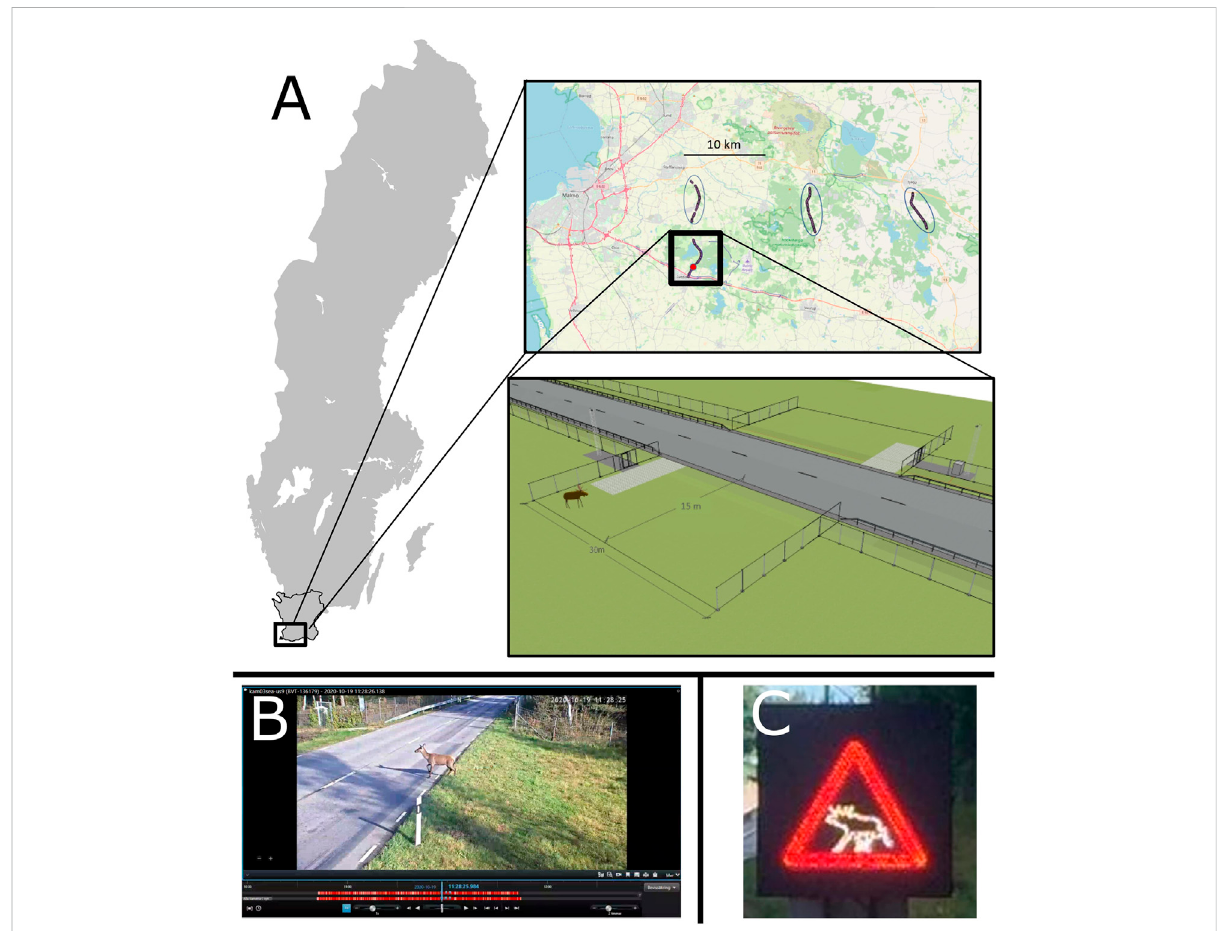
FIGURE 1 (A) Top:Locationoftheat-gradefaunapassageinsouthernSweden,inSkåneCounty.Road108isshownthenblackbox,andtheexactlocation ofthe fauna passage is shown byared dot. The threeunmitigated reference road sectionsare shown inblue ovals (Basemap:OpenStreetMaps). The schematic below the localized map shows a technical drawing of the at-grade fauna passage, with a 30 m wide opening in the fence with the roadside verge detection zones on each side of the road, where the animals are detected by the video surveillance system before crossing the road. (B) Bottom left: An example of a video as viewed from the Milestone XProtect video management software. (C) Bottom right: An example of warning sign A19-1, displayed on the variable message sign to warn drivers of an animal within the at-grade fauna